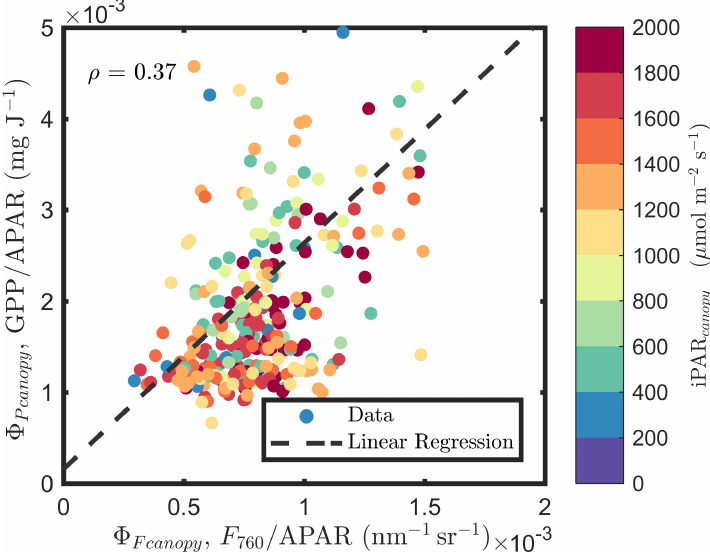
Figure A1. Relationships between (cid:56) F 2017 growing season, with 30min temporal resolution during daylight hours.